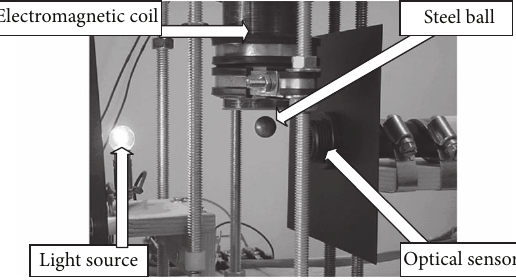
Figure 6: Stable levitation of steel ball.